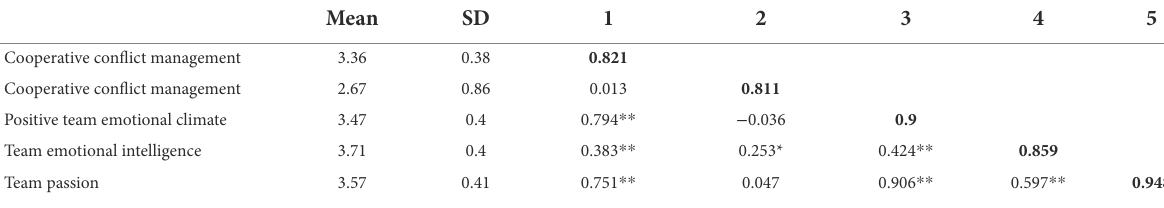
TABLE 1 Descriptive statistical analysis and